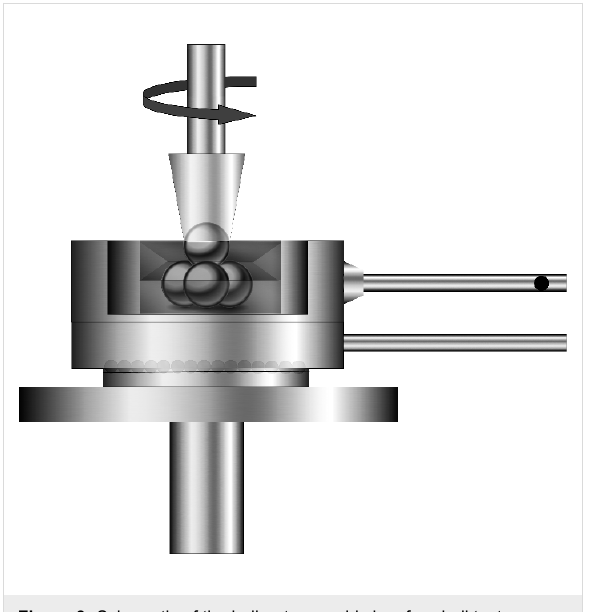
Figure 3: Schematic of the ball-pot assembly in a four-ball